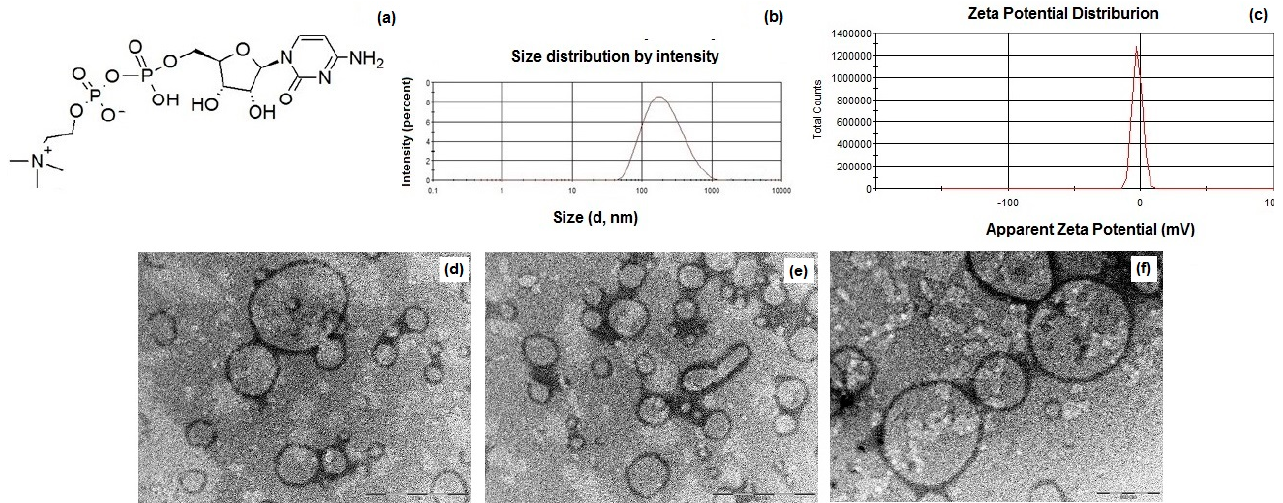
Figure 1. ( a ) Chemical structure of citicoline (CIT); ( b ) particle size distribution of CIT-SLNs; ( c ) zeta potential distribution of CIT-SLNs; ( d – f ) TEM images of CIT-SLNs [the scale bar of panels ( d ) and ( e ) is equal to 1 µm, while in ( f ) corresponds to 500 nm]. (For further details on TEM images and particle size, see Figure S1 and Excel Sheet S1 in Supplementary Materials).